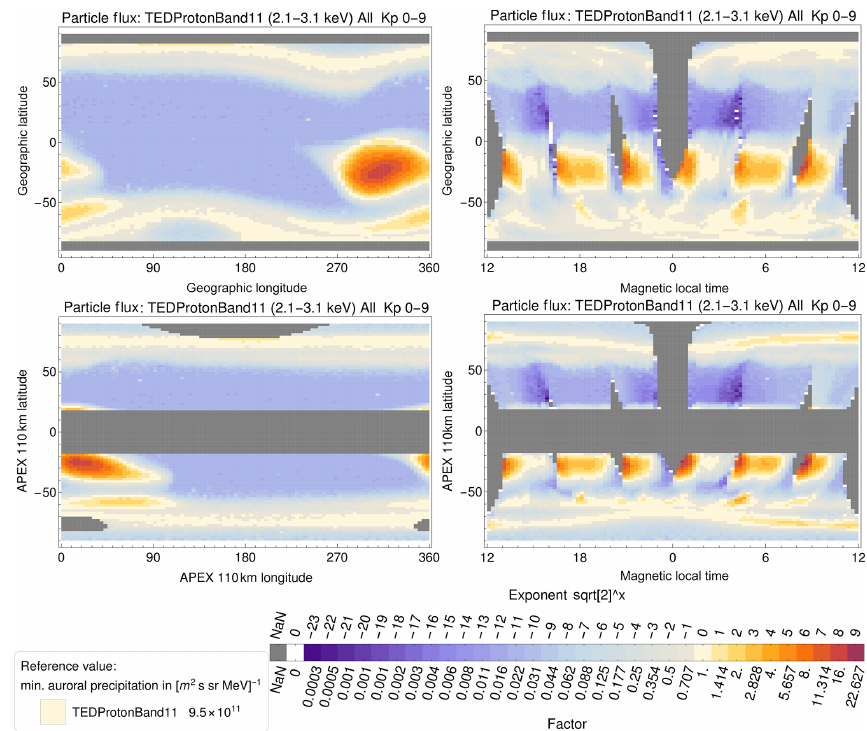
Figure 1. Particle flux in TED proton band 11 in geographic and modified APEX 110km coordinates. The colour scale marks the minimum flux in the auroral oval in beige. The neighbouring colour indicates that the flux is a factor